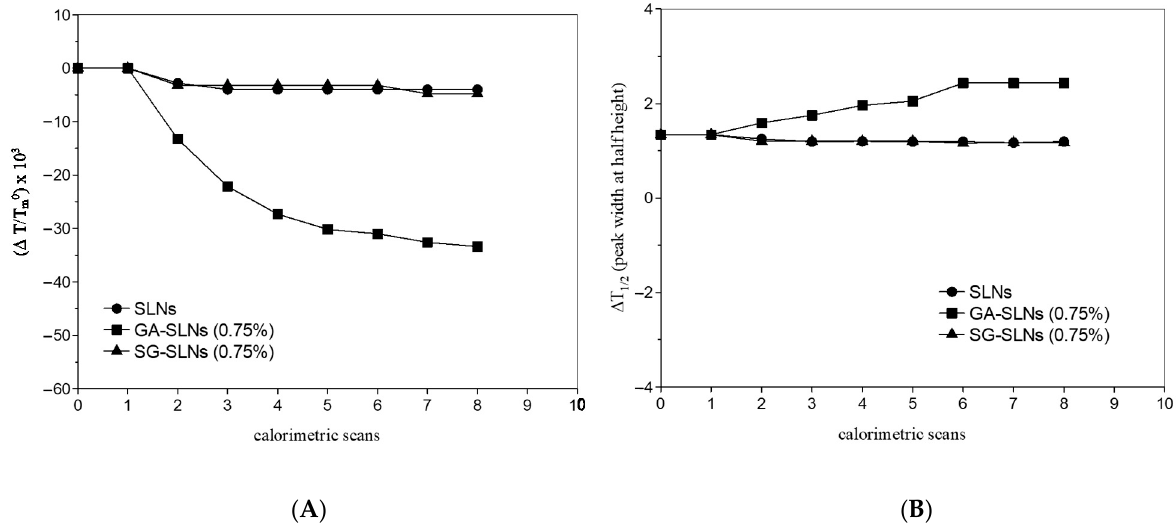
Figure 6. ( A ) Transition temperature variations—made using Δ T/T m0 ( Δ T = T m – m0 , where T m0 is the transition temperature of MLVs and T m is the transition temperature of MLVs put in contact with SLNs, GA-SLNs (0.75%), and SG-SLNs (0.75%)— as a function of the calorimetric scans. ( B ) Δ T 1/2 (peak width at half height; °C) of MLVs put in contact with SLNs, GA-SLNs (0.75%), and SG-SLNs (0.75%) as a function of the calorimetric scans.